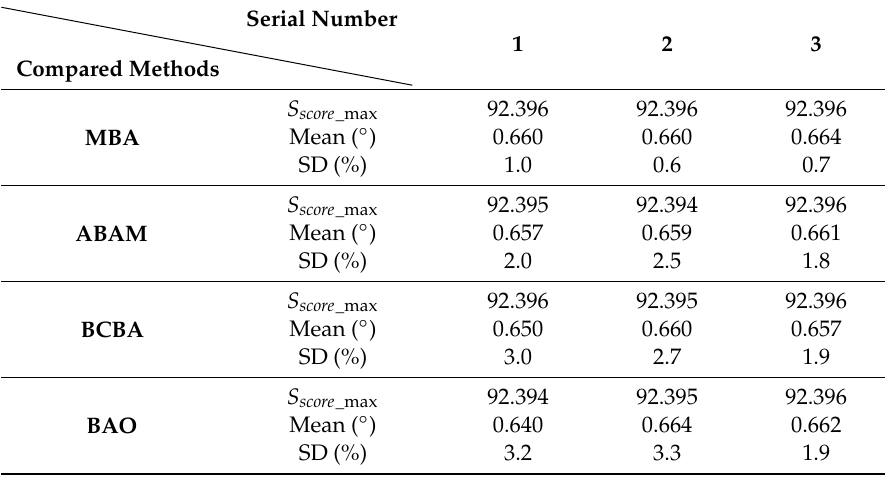
Table 3. The performance comparison results of the four di ff erent